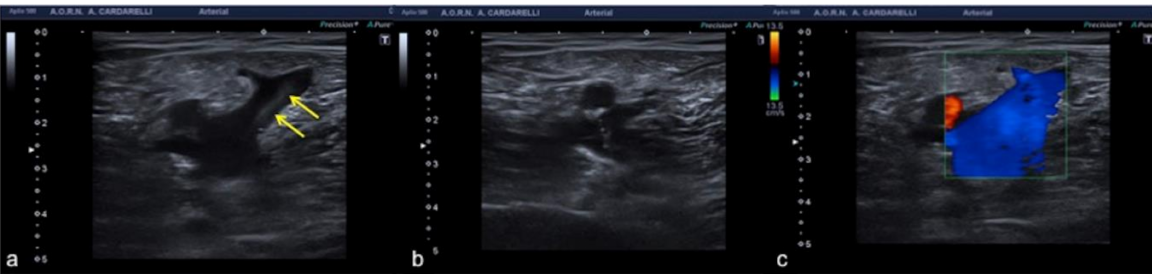
Figure 25. Rouleaux formation over the venous valves ( a , arrows). After distal compression, the blood was squeezed and the rouleaux was finally cleared ( b , c ).